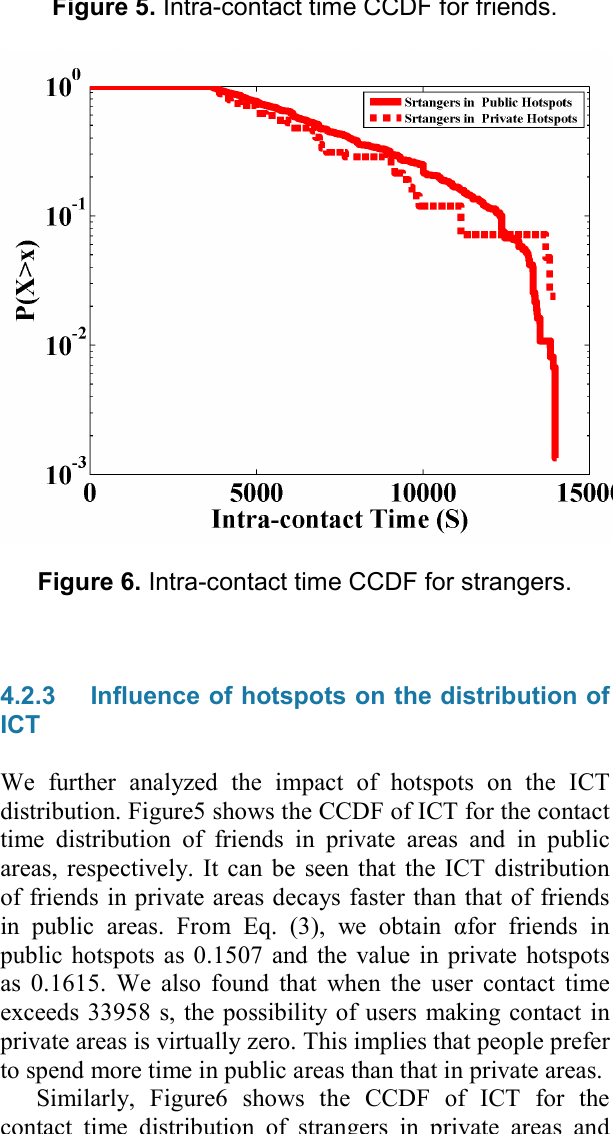
Figure 5. Intra-contact time CCDF for friends.